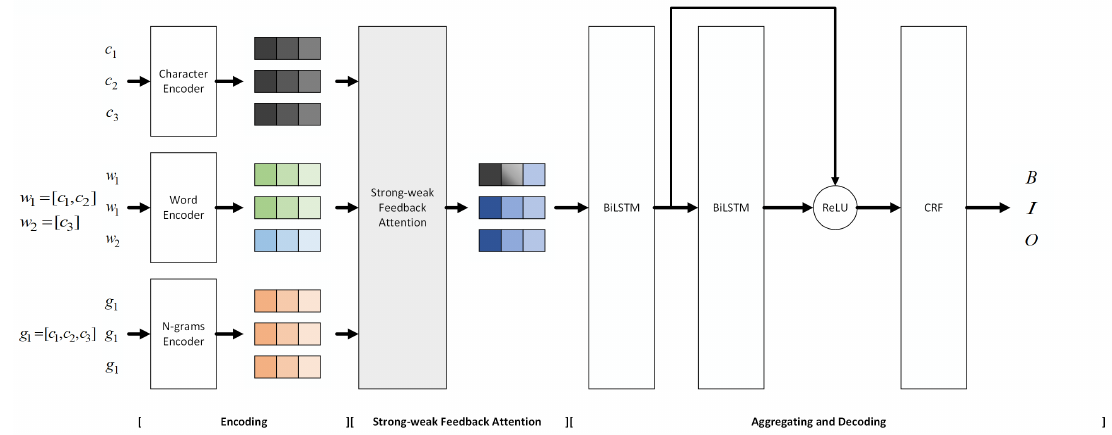
Figure 1. The architecture of